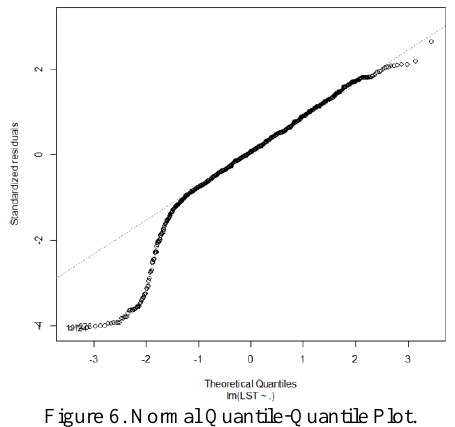
Figure 6. Normal Quantile-Quantile